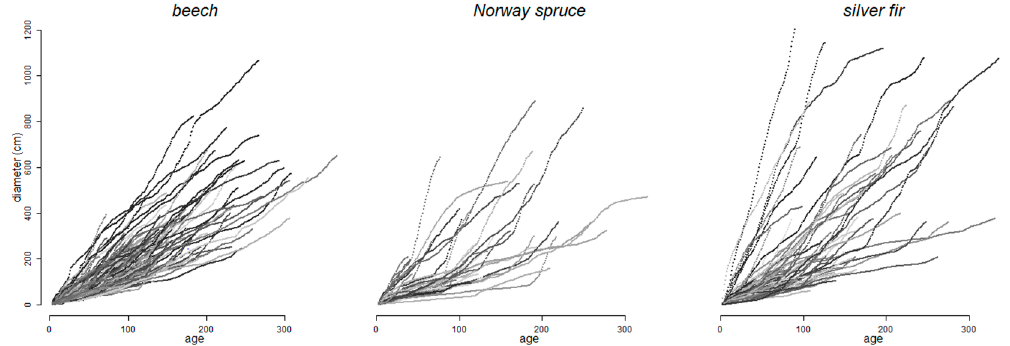
Figure 2. DBH–age relationship in Penteleu 1 ha mixed–virgin forest plot. All three biwavelets among pairs of species (Figure 3) contain regions with signifi- cant wavelet coherence among dendrochronological series of pairs of species. Anti-phase silver fir–Norway spruce biwavelets tend to be in phase when there is a lag in the phase.